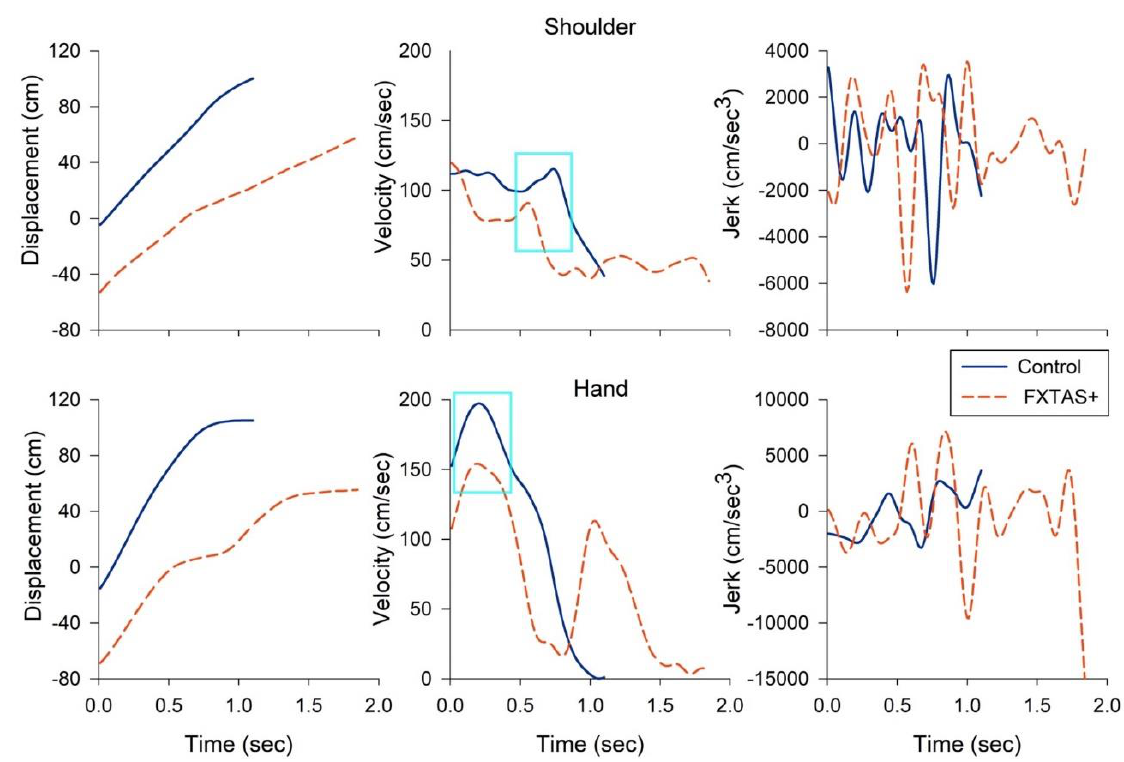
Figure 3. Representative kinematic profiles of the shoulder (top) and hand (bottom) of a 65-year-old patient with FXTAS (dashed orange line) and an age-matched healthy control (solid blue line) when they walked to reach and lift the small box. The FXTAS patient showed a prolonged reaching duration (left), decreased maximum reaching velocity of the shoulder and hand (middle, highlighted in a cyan box), and more oscillatory and jerkier joint movement (right) relative to the control participant. Time series were graphed from the reaching onset to offset. Jerk trajectories are shown in absolute values (cm/s 3 ). Table 3. Reaching outcomes (mean (SD)) during dynamic walking trials for the healthy controls and premutation carriers with and without FXTAS.